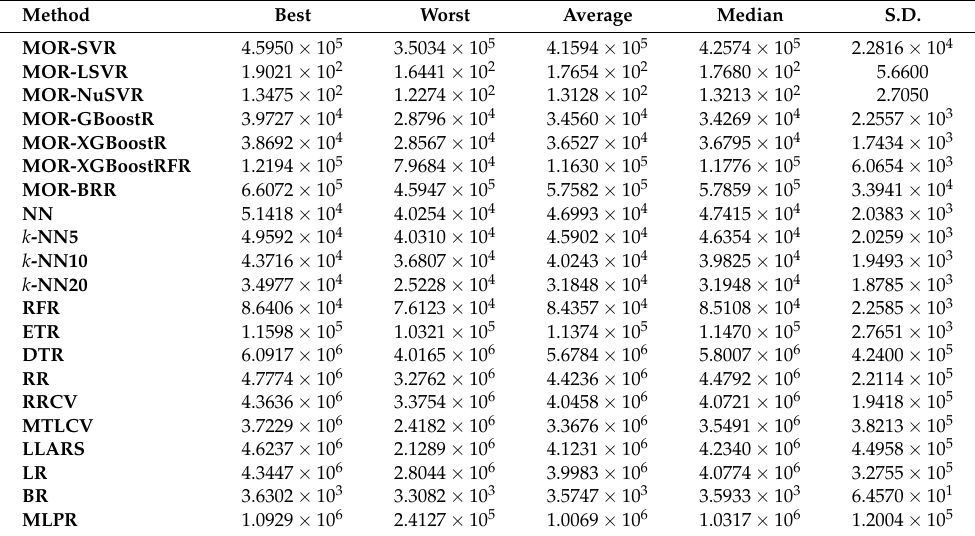
Table 7. Prediction speed (in observations per second (obs/s)) for all methods over 50 statistical runs (second